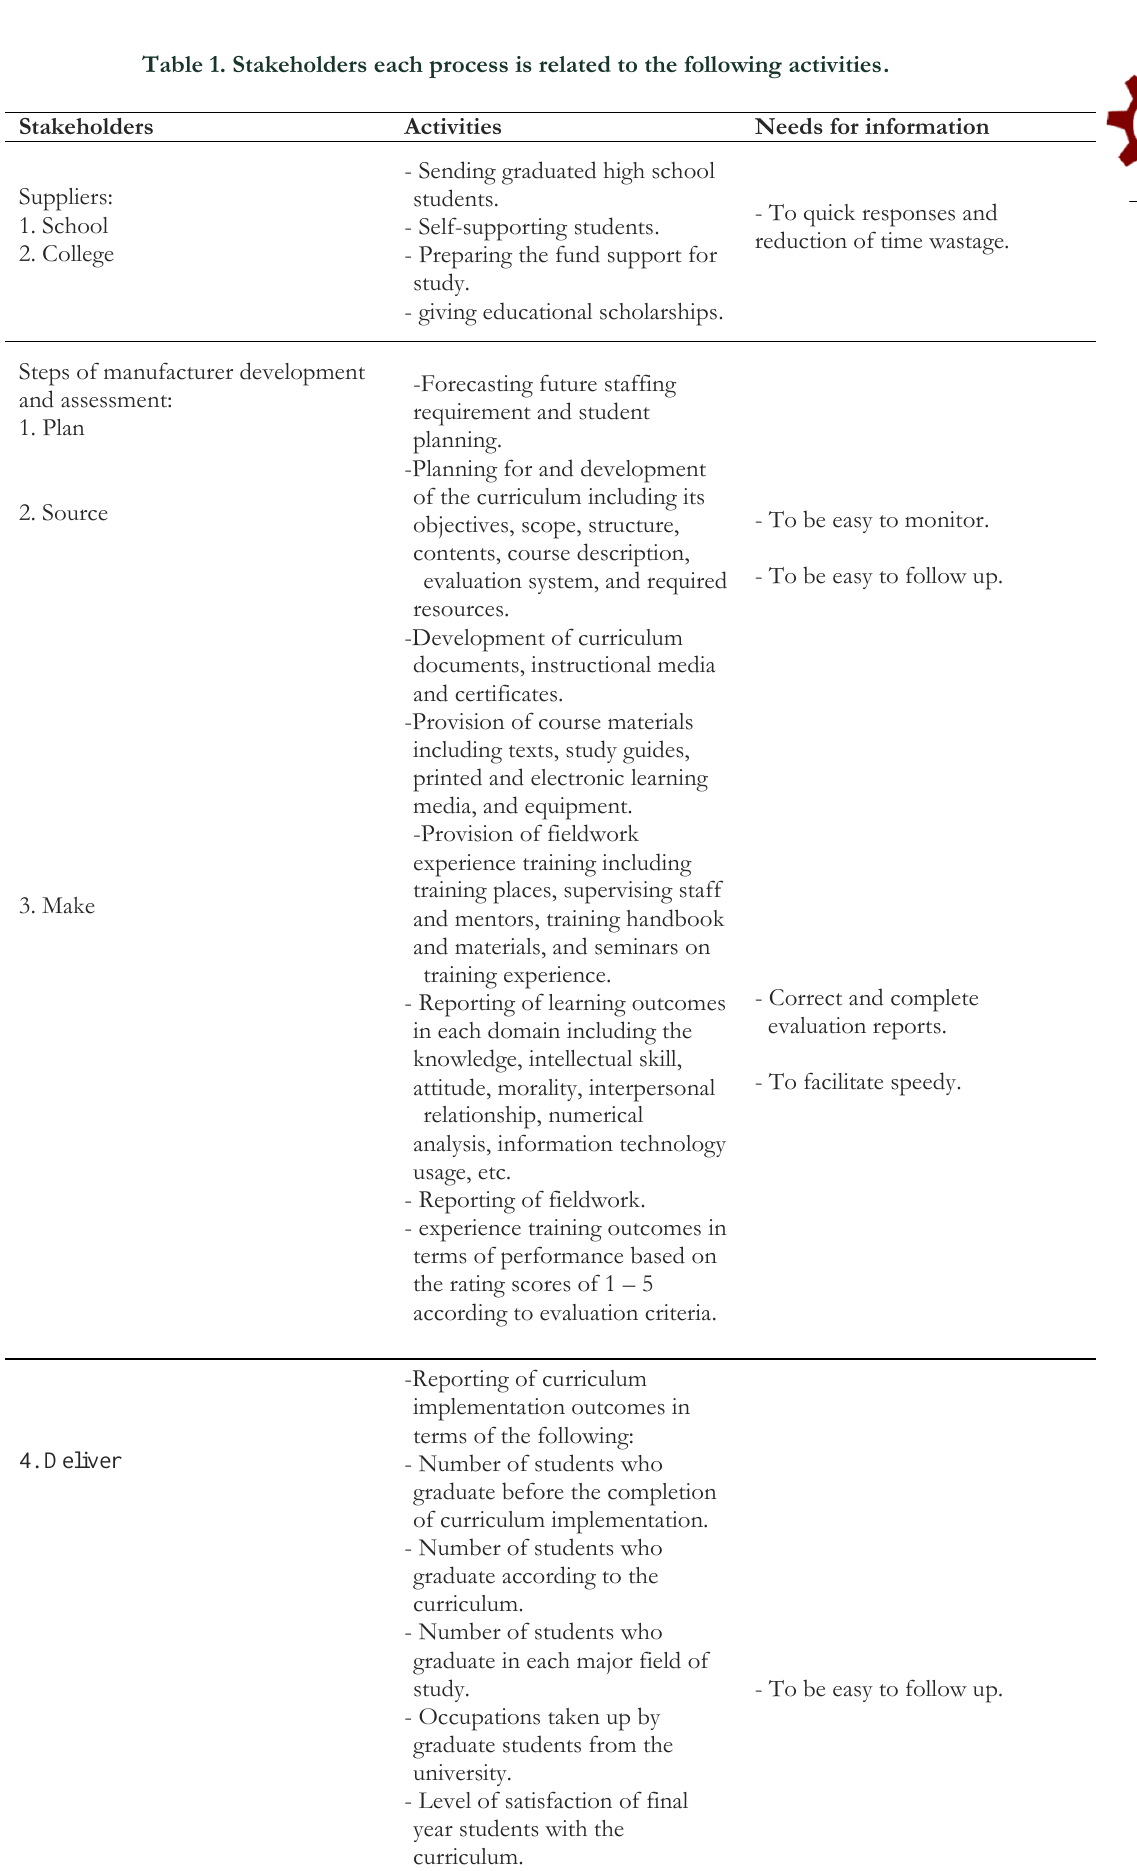
Table 1. Stakeholders each process is related to the following